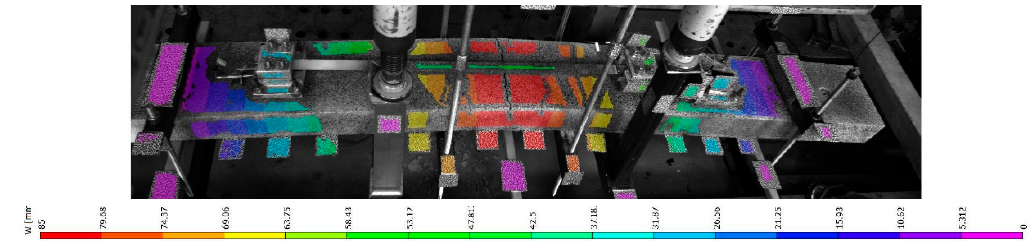
Figure 12. Vertical displacement of beam SMA_1 obtained from DIC.